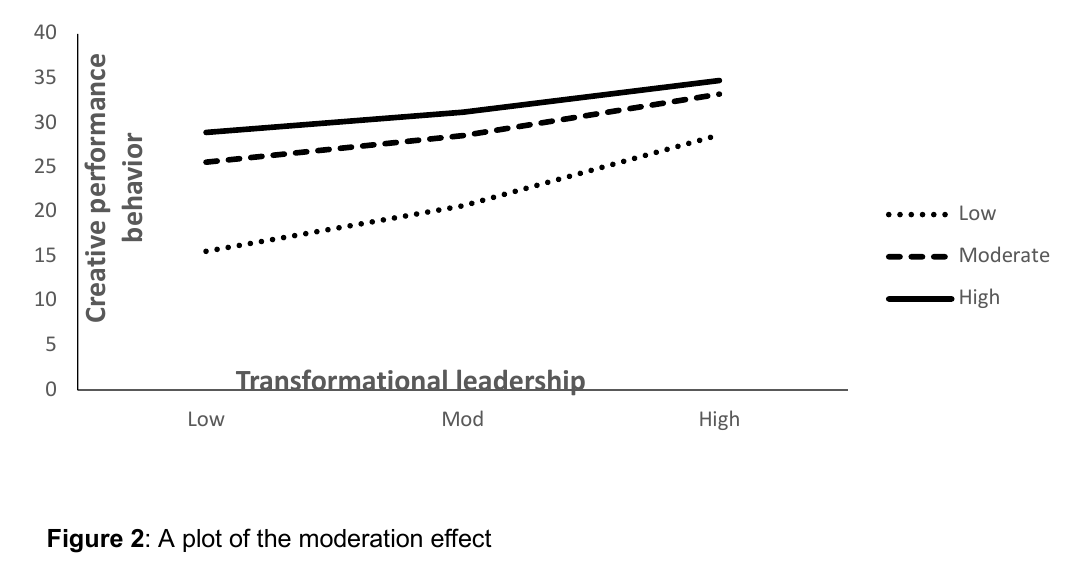
Figure 2 : A plot of the moderation